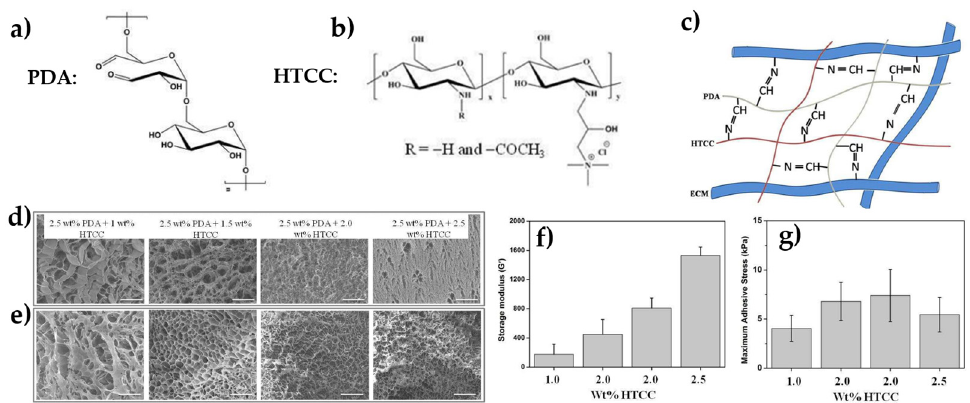
Figure 3. Chemical structure of oxidized dextran ( a ), the cationic chitosan derivative ( b ) and the OD-HTCC hydrogel ( c ). Surface ( d ) and cross-section ( e ) SEM images of the hydrogels at different HTCC concentrations. Scale bar 50 μ m. Storage modulus of the hydrogel as a function of HTCC concentration ( f ) and adhesive strength measured using porcine skin ( g ). Adapted with permission from [50].